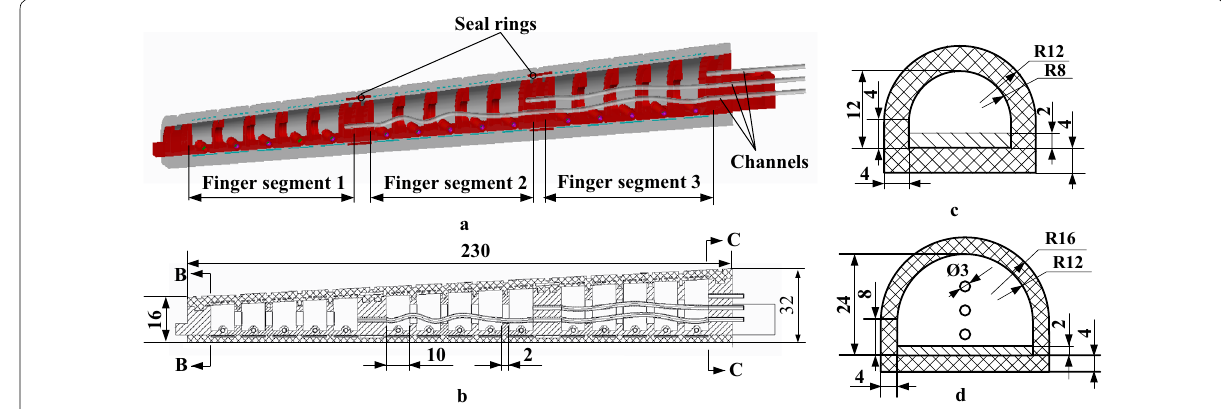
Figure 2 a Configuration of an entire soft finger; b Cross-section view; c B–B section view; d C–C section view (unit: mm)